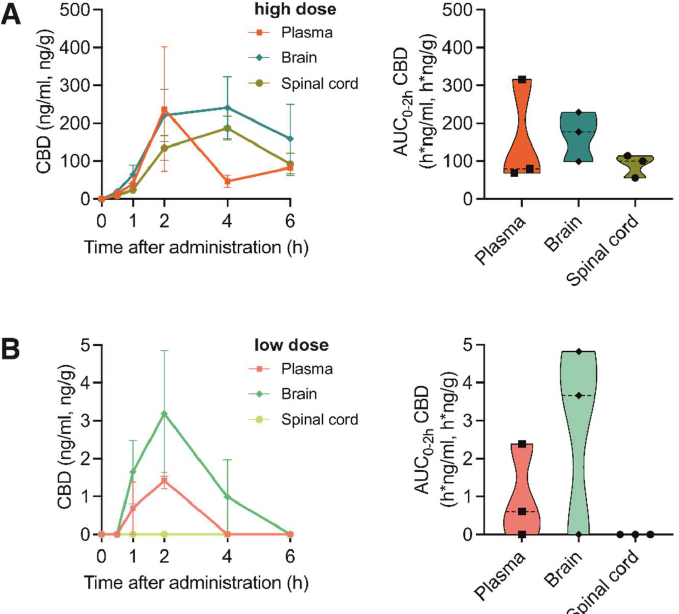
Figure 3. Pharmacokinetic profile of CBD after oral administration of high and low doses of pure CBD compound. ( A ) Left: Concentration-time profiles of CBD in plasma, brain and spinal cord at 0, 1, 2, 4 and 6 h after oral administration of 20 mg/kg pure CBD compound. Data are represented as mean ± SEM, n = 3 per timepoint. Right: AUC 0–2h of CBD concentrations. ( B ) Left: Concentration-time profiles of CBD in plasma, brain and spinal cord at 0, 1, 2, 4 and 6 h after oral administration of 1 mg/kg pure CBD compound. Data are represented as mean ± SEM, n = 3 per timepoint. Right: AUC 0–2h of CBD concentrations.